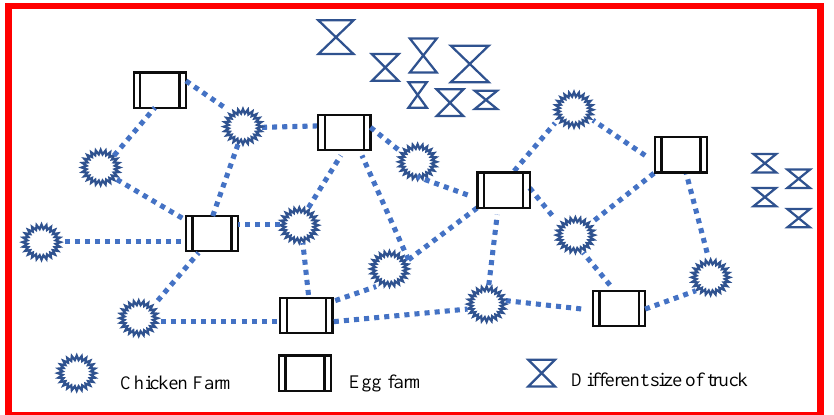
Figure 1. Unsolved problem.